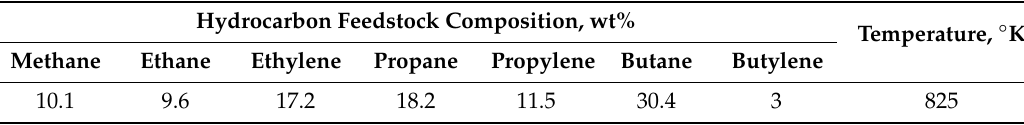
Table 2. Model input data on propane-butane